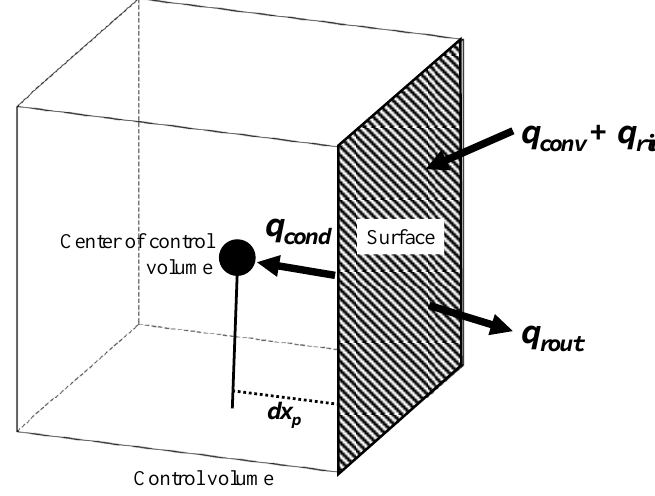
Figure 6. Heat balance diagram.